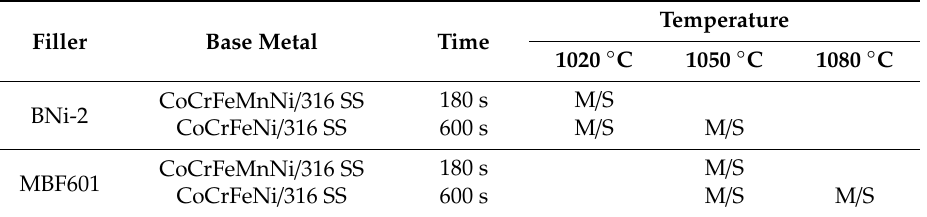
Table 1. Brazing conditions in the